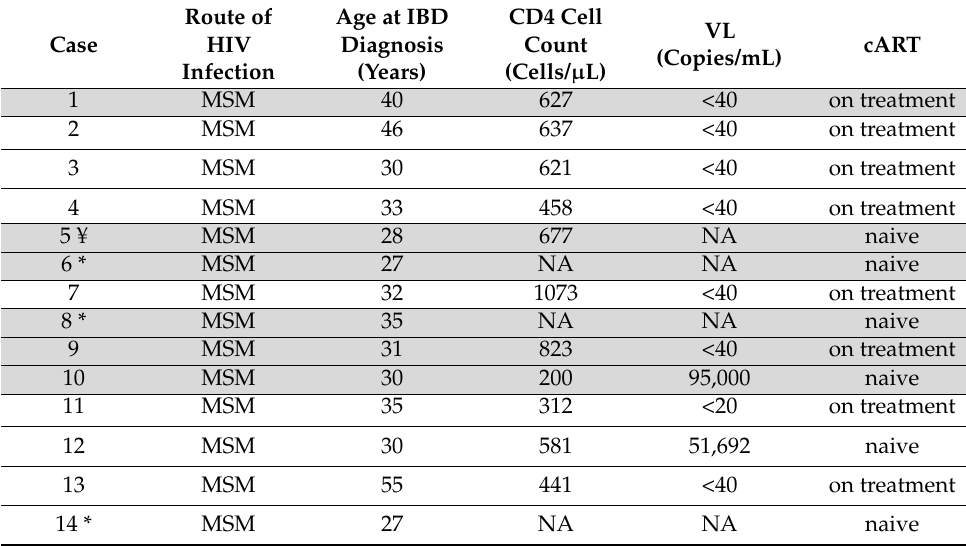
Table 1. The patients’ characteristics concerning HIV infection status and treatment at the time of IBD